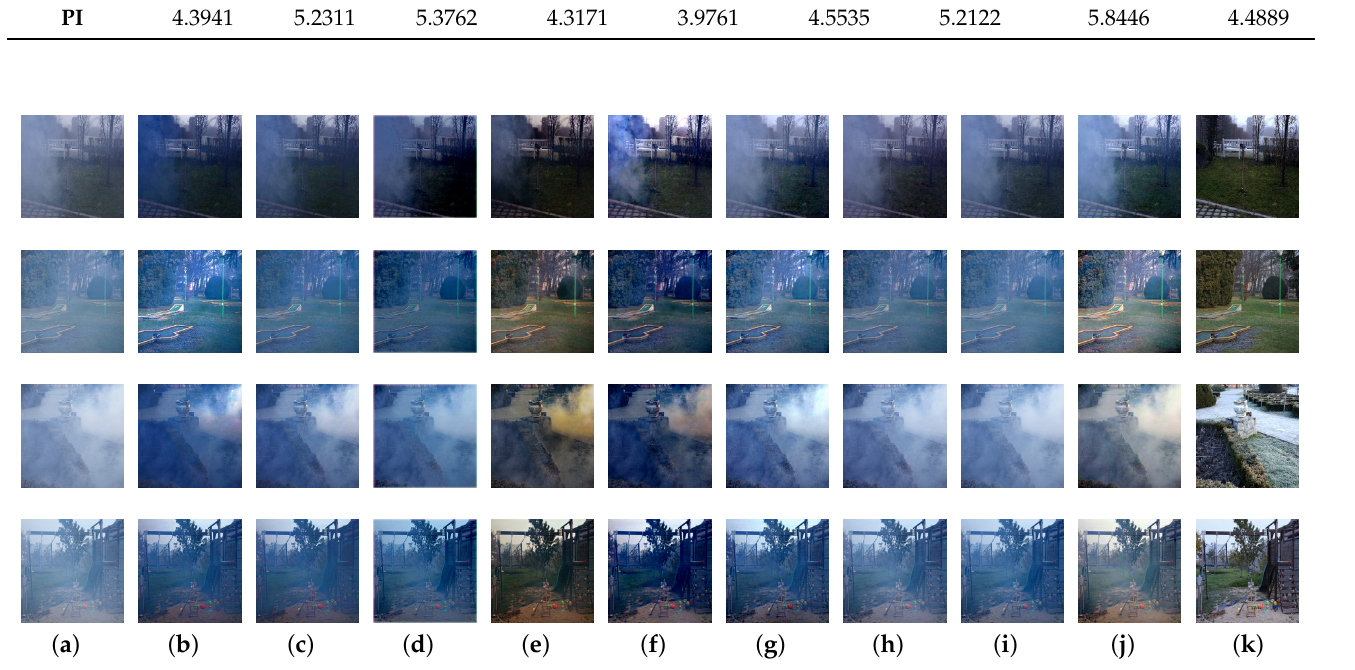
Figure 13. Visual results on the NTIRE dehazing challenge datasets with the network training on RESIDE datasets: ( a ) hazy images; ( b ) DCP; ( c ) CAP; ( d ) AODNet; ( e ) EPDN; ( f ) GCANet; ( g ) pix2pix; ( h ) FFA-Net; ( i ) two-branch; ( j ) our proposed method; ( k ) corresponding haze-free